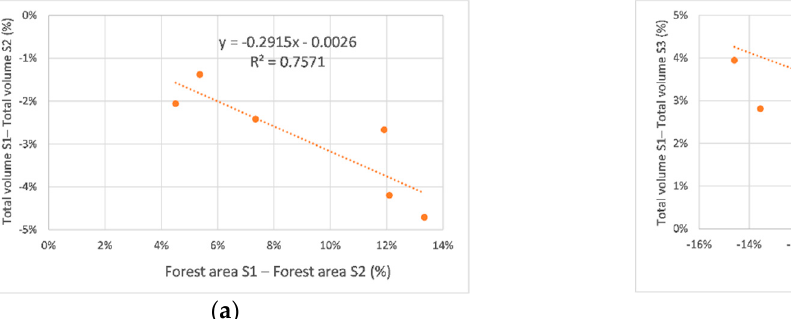
Figure 15. Comparative analysis of the total volume of water drained during the events and the differences in forested areas, between the three scenarios S1, S2 and S3. ( a ) S1 compared with S2; ( b ) S1 compared with S3.